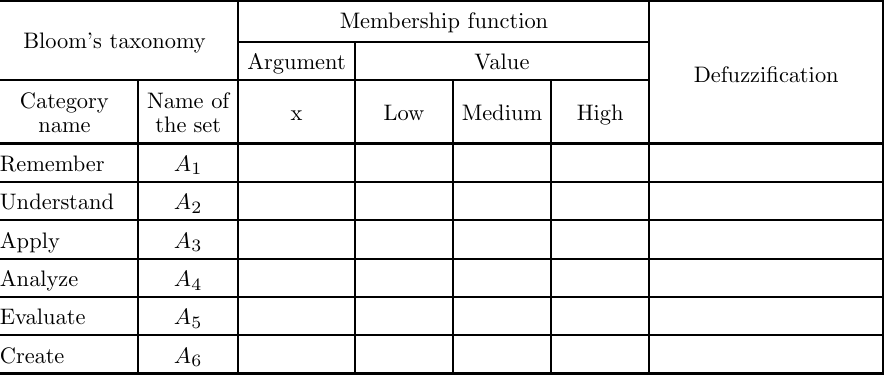
Table 1. Learning Outcome Bloom’s